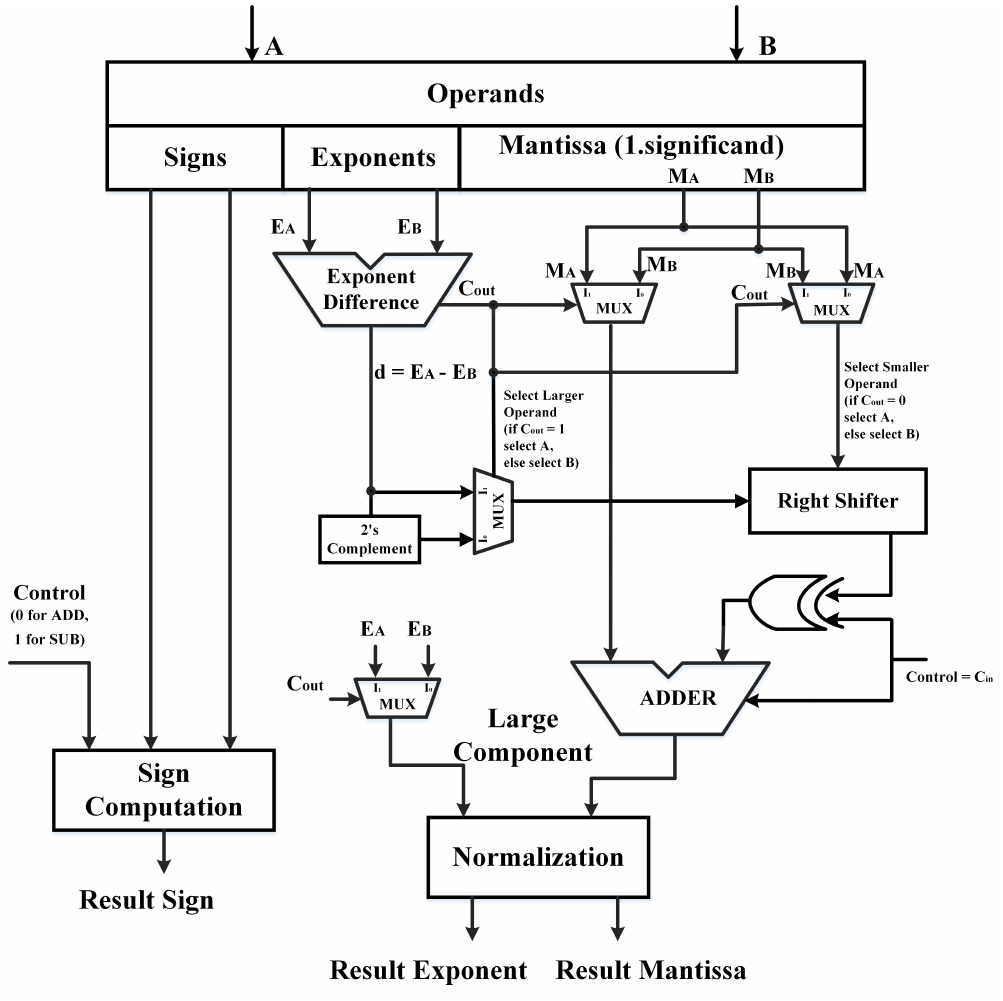
Figure 4. Basic asynchronous floating-point adder (AFPA)